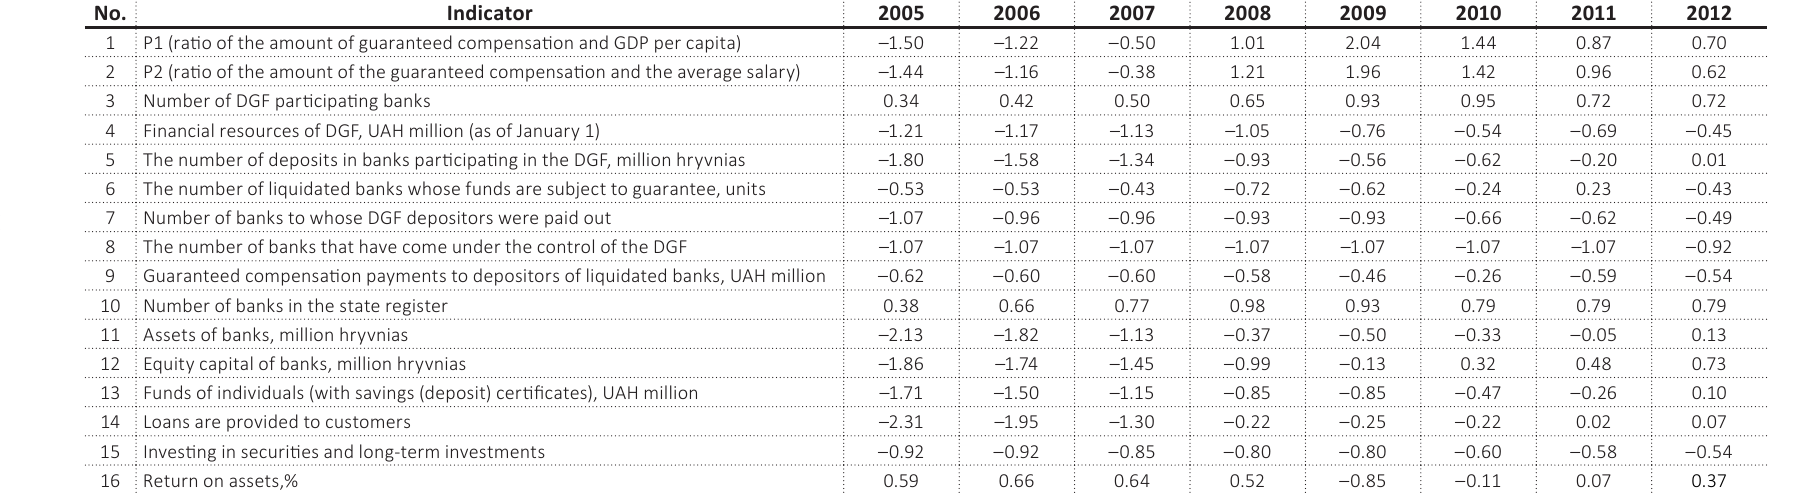
Table А3. Standardized values of deposit insurance indicators in Ukraine in 2005–2012